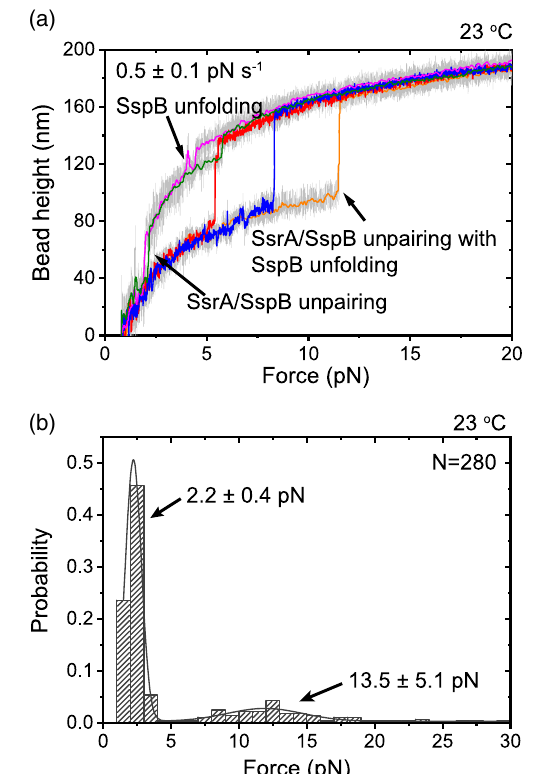
FIG. 2. Mechanical stability of the SsrA/SspB complex. (a) Five representative force-extension curves of the SsrA-SspB construct obtained at a force-loading rate of 0 . 5 (cid:1) 0 . 1 pN s − 1 under ambient light conditions. The color lines show a 20-FFT smooth of the raw data (gray). (b) Normalized histograms of the SsrA/ SspB complex unpairing forces at a force-loading rate of 0 . 5 (cid:1) 0 . 1 pN s − 1 . N indicates the number of data points obtained. The dark gray curve is a double Gaussian fitting SsrA/SspB complex, which are unpaired at 2 . 2 (cid:1) 0 . 4 ð 0 . 03 Þ